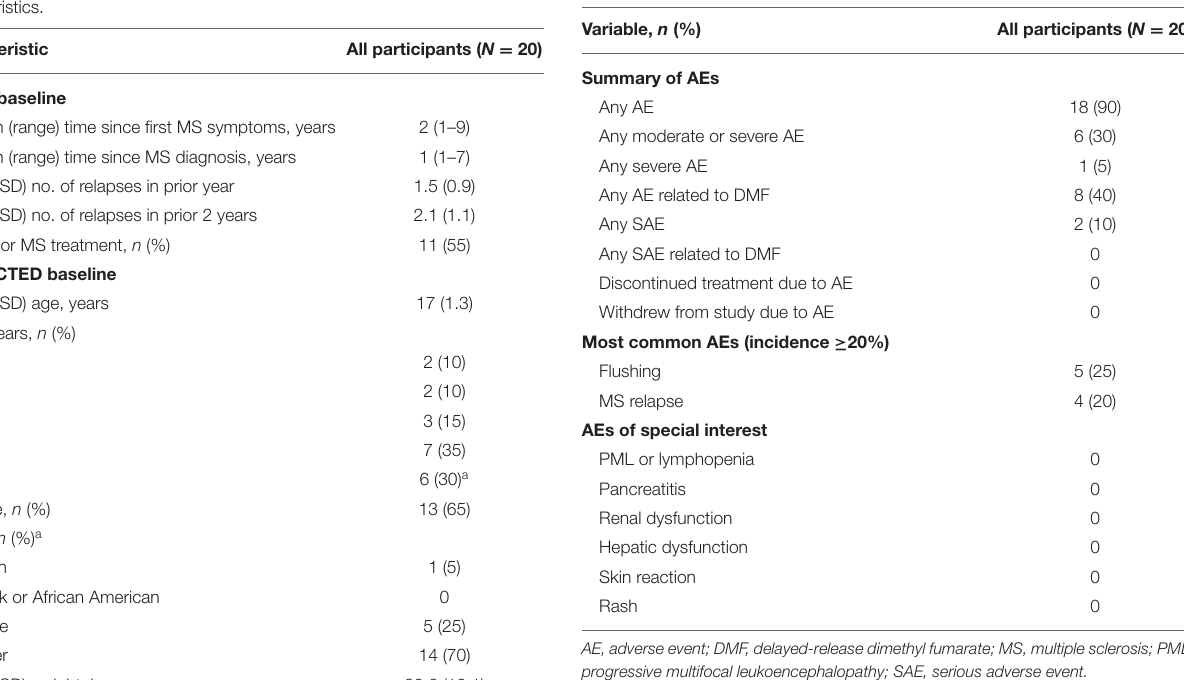
TABLE 2 | Safety summary for the CONNECTED